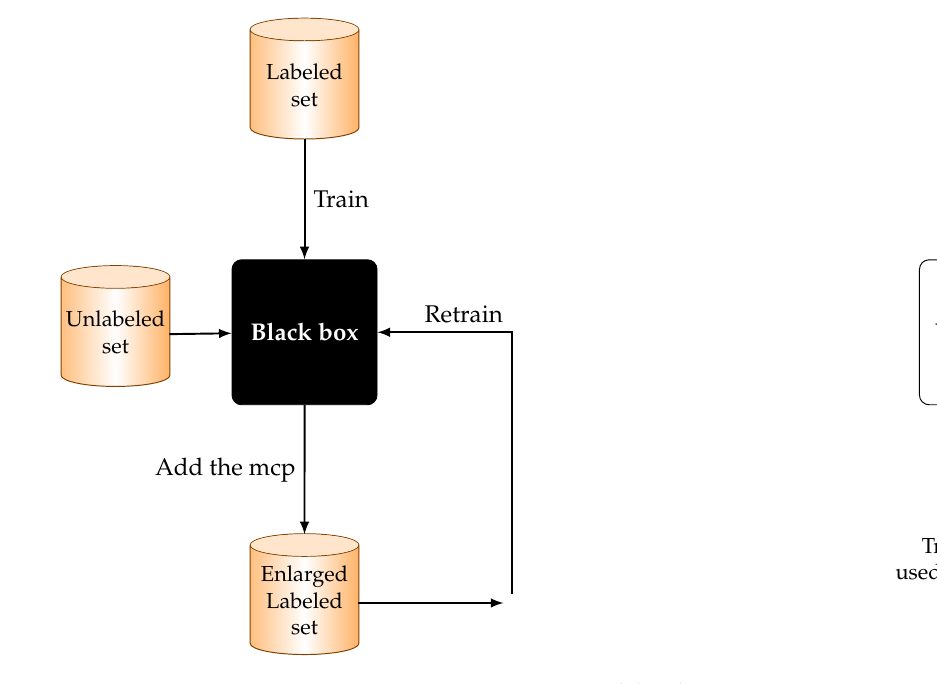
Figure 1. Grey-Box model